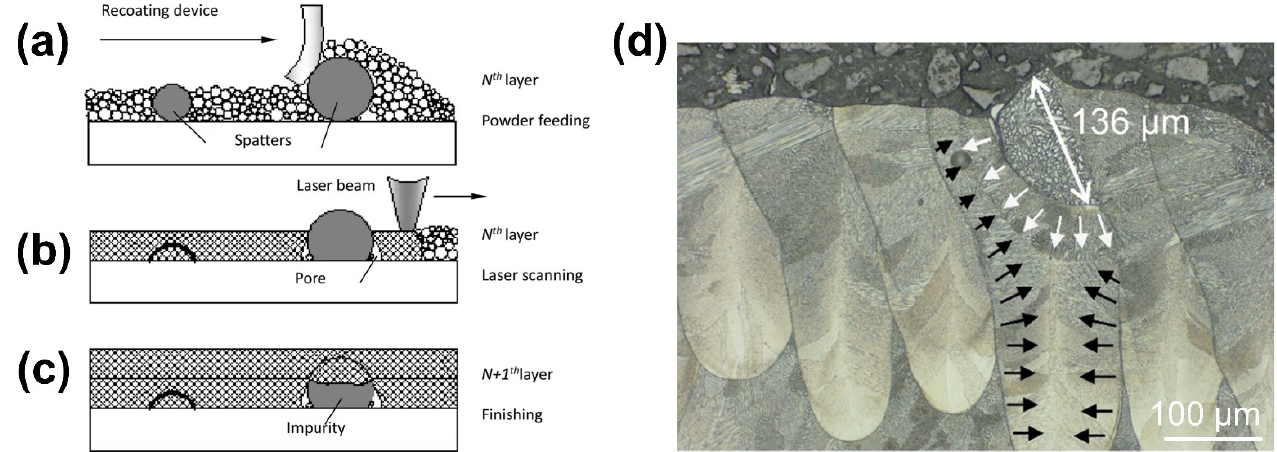
Figure 14. The effect of spatter on re-coating powder. ( a ) Pre-placing powders will be blocked when the next powder layer spreads; ( b ) spattering particles impede circulation of powders and cause voids nearby (before laser melting); ( c ) laser scanning can completely melt small spatter to achieve metallurgical bonding, while large spatter can only melt some of them. (Reprinted with permission from Ref. [63]. Copyright 2016 Elsevier B.V.). ( d ) A spatter particle of cross-section ~136 µm incites a solidification front (schematized with white arrows) that competes with the solidification fronts in the melt pool (schematized with black arrows). (Reprinted with permission from Ref. [82]. Copyright 2021 Elsevier B.V.).